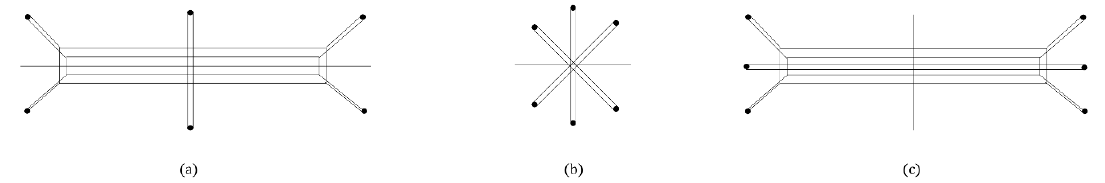
Figure 2 . The brane web one gets by gauging part of the global symmetry of the 5 d su (10) SCFT we get through the compacti(cid:12)cation of the 6 d su (2) + 10 F theory with the appropriate holonomy. Speci(cid:12)cally, we gauge both of the su (5) subgroups inside the su (10) global symmetry group, with an hypermultiplet in the antisymmetric for both su (5) groups. In (a), we show the resulting brane web in the limit where both the su (5) gauge groups are weakly coupled. In (b), we show the resulting brane web at the SCFT point. In (c) we show the web, after an S-duality, in the limit of negative but weak (in absolute value) coupling. At this point the system is described by a dual su (6) (cid:2) su (6) gauge theory, with a bifundamental hypermultiplet, and a fundamental hyper plus a half-hyper in the 20 for each su (6) gauge